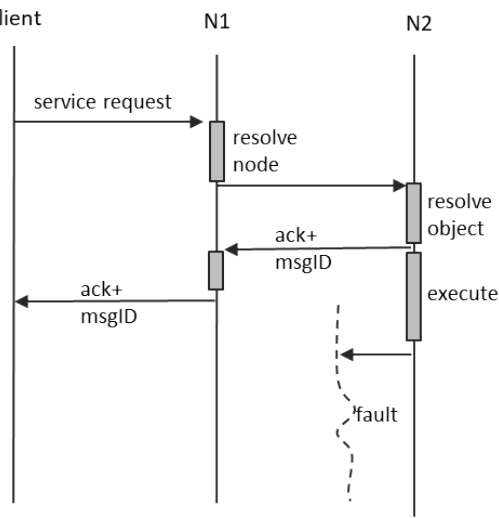
Figure 7. Fault during service